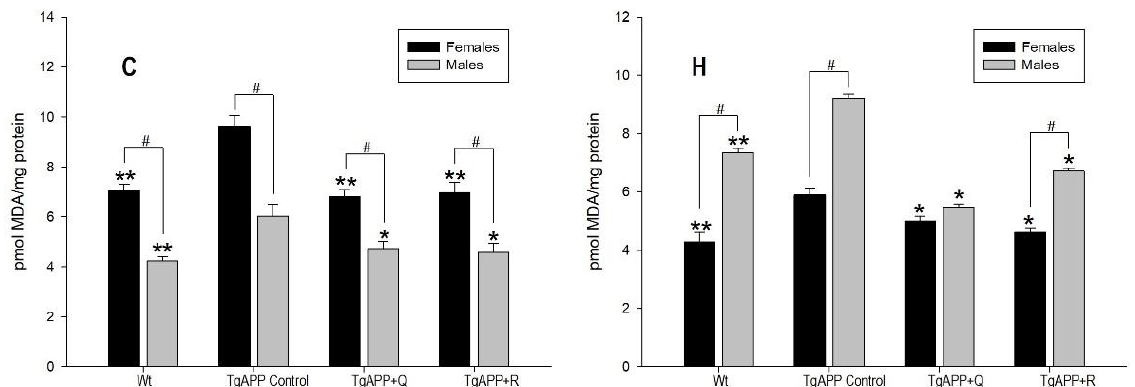
Figure 3. Effect of quercetin (Q) and rutin (R) on MDA levels. Cortex (C) and Hippocampus (H). (1) WT; (2) TgAPP control; (3) TgAPP + Q; (4) TgAPP + R. * p < 0.05 or ** p < 0.001 vs. TgAPP control (ANOVA followed by the post-hoc Newman – Keuls multiple comparison test); # p < 0.05 (Student t - test).